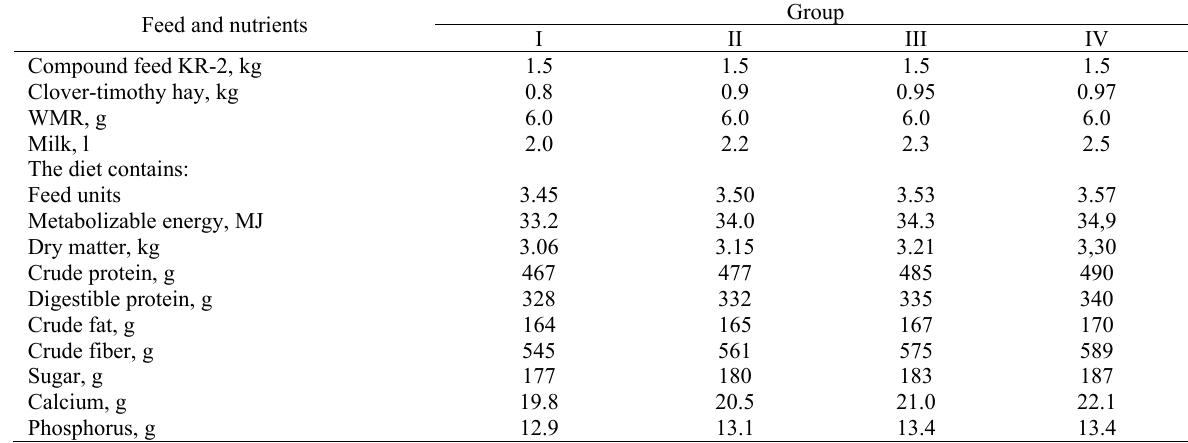
Rations of experienced